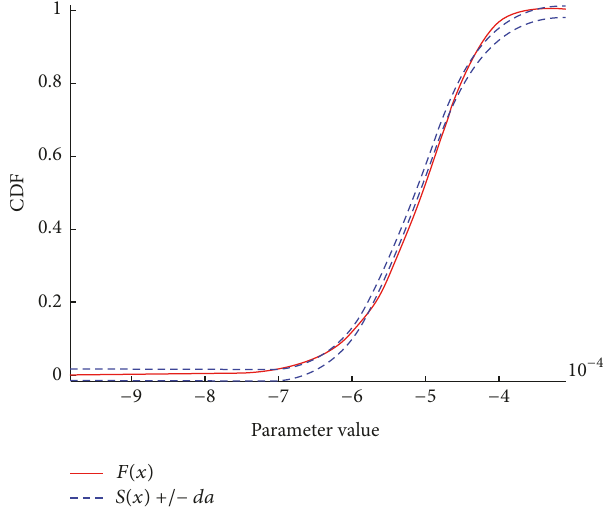
Figure 3: Kolmogorov-Smirnov test for parameter 𝑎 11 (RC to SS transformation, 𝛼 = 0.05, 𝑁 = 10 4 )